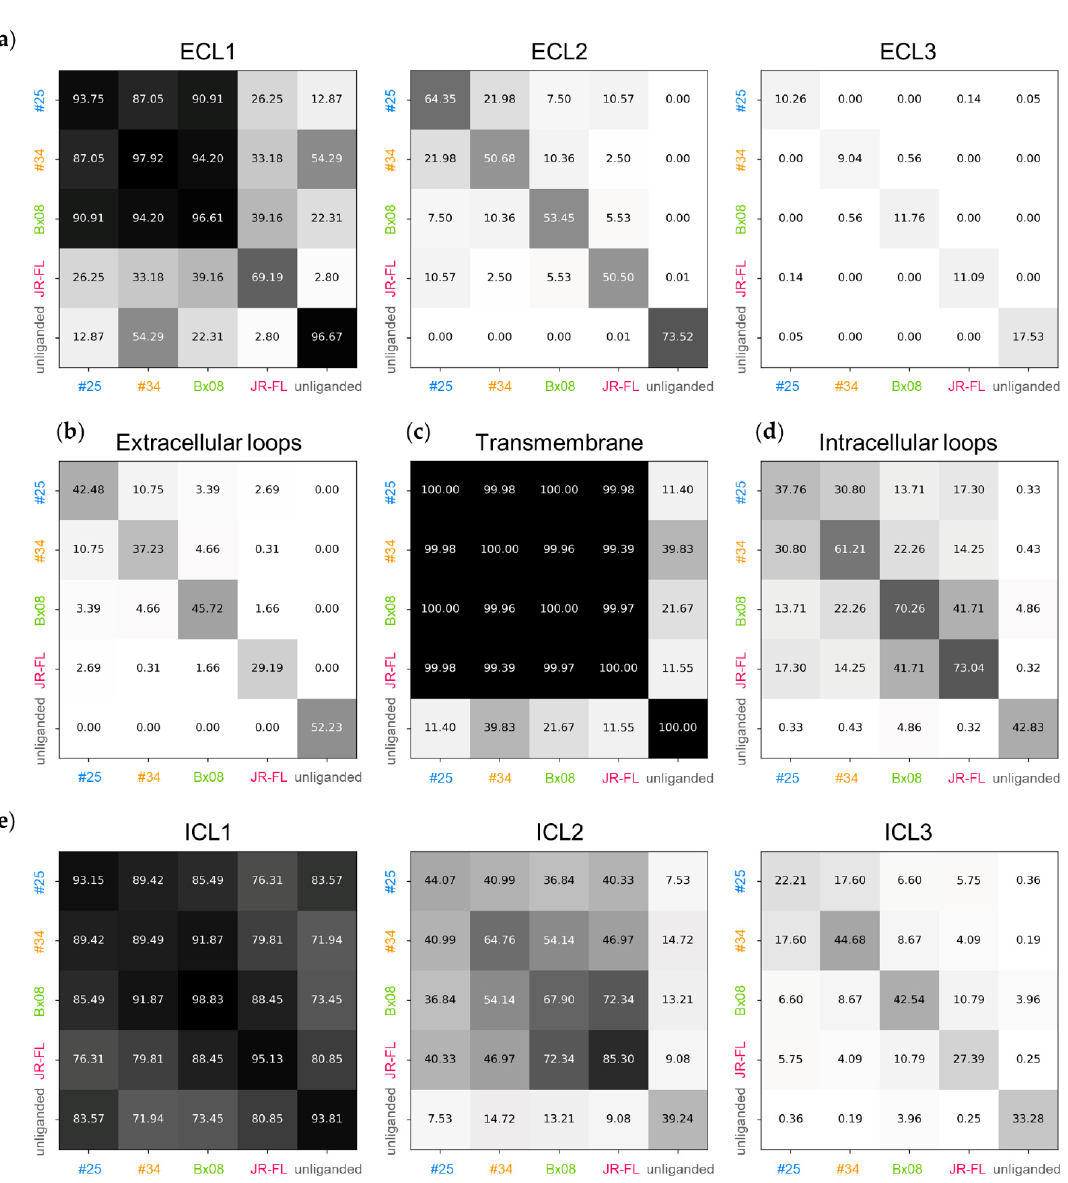
Figure 3. Percent of common positions of the CCR5 loops and 7-TMs: ( a ) ECL1, ECL2 and ECL3; ( b ) the three ECLs; ( c ) 7TMs; ( d ) the three ICLs; ( e ) ICL1, ICL2 and ICL3; ( a – e ) all structures were 3D-aligned on the input coordinates of CCR5 TMs. The proportion of common conformations is computed from the all-against-all comparison of one in ten snapshots issued from the simulation of the same complex (diagonal of the matrix) or the systematic pairwise comparison of one in ten snapshots issued during the simulation of two different complexes (off-diagonal terms of the matrix). Position is common to two snapshots if the deviation of the C α coordinates of the domain is low (RMSD < 2 Å).